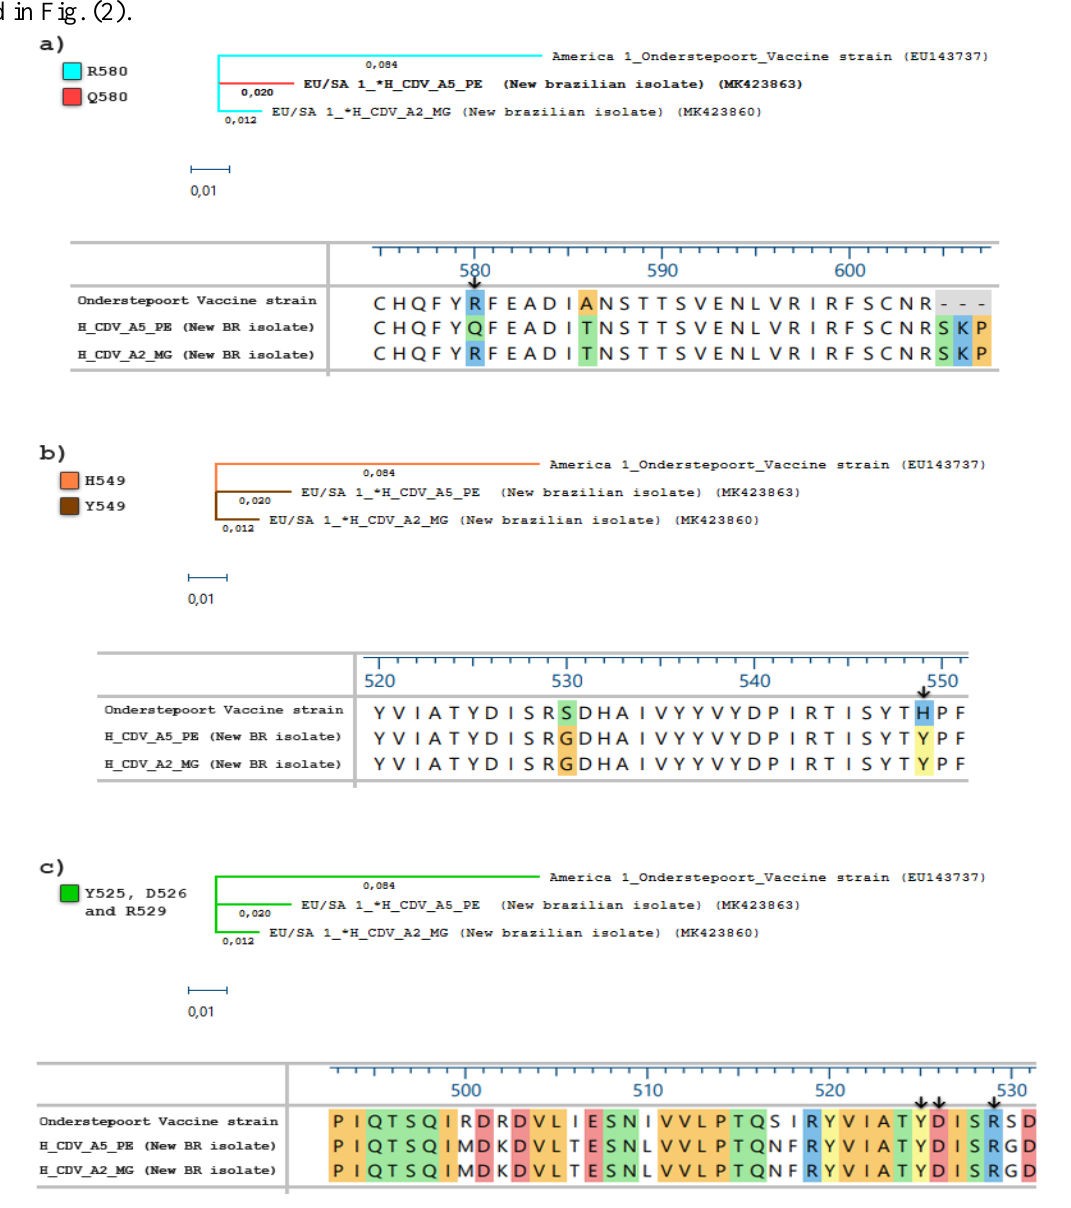
Fig. 2: Analysis of amino acid sequence polymorphisms in the new isolates described in this study in comparison with “O ” ( : EU143737). S q 607 g ORF each of the newly described strain w g w q “O ”